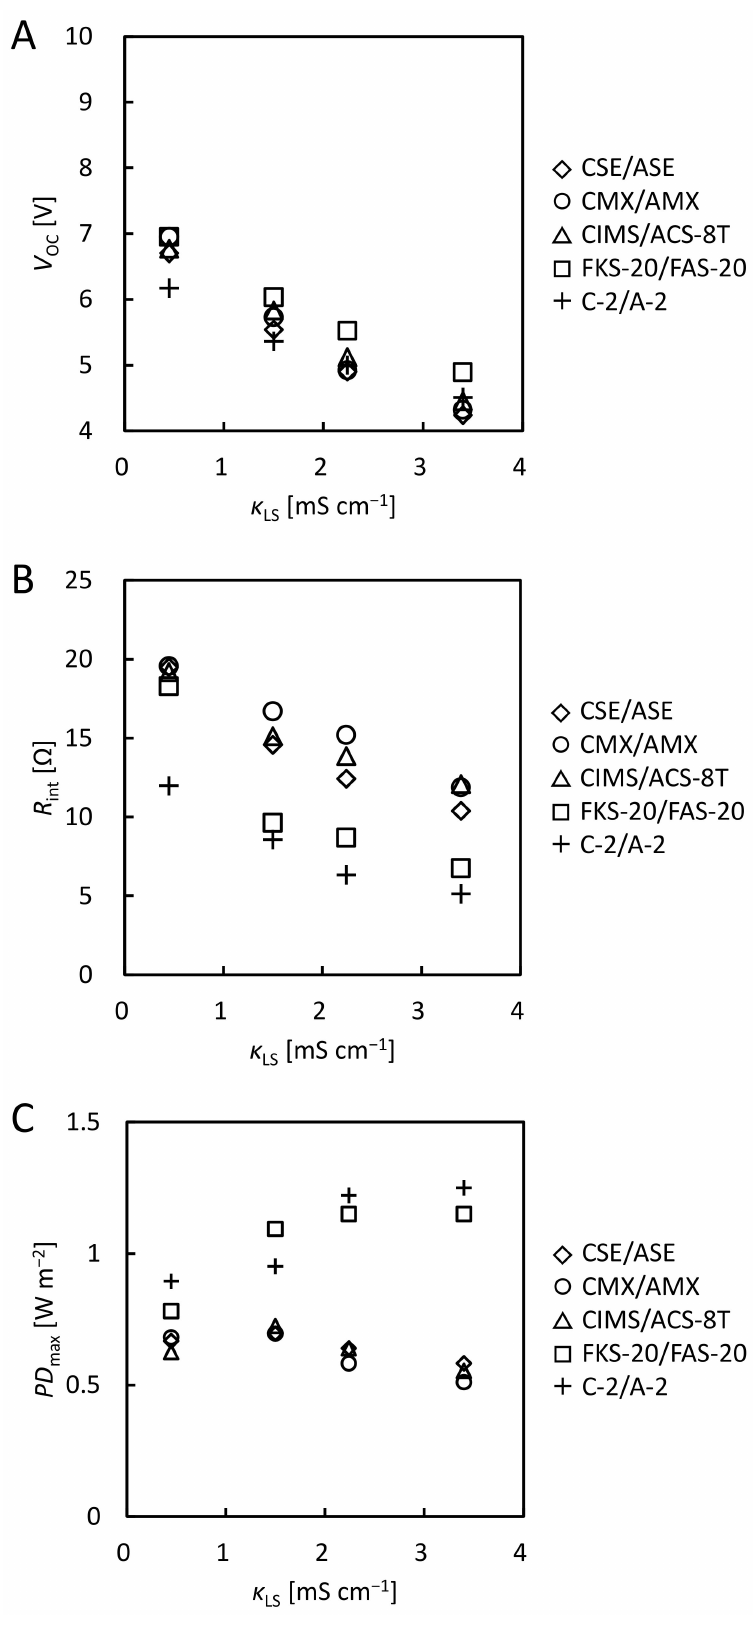
Figure 4. κ LS dependence of ( A ) V OC , (B) R int , and (C) PD max using natural SW as HS and surface water as